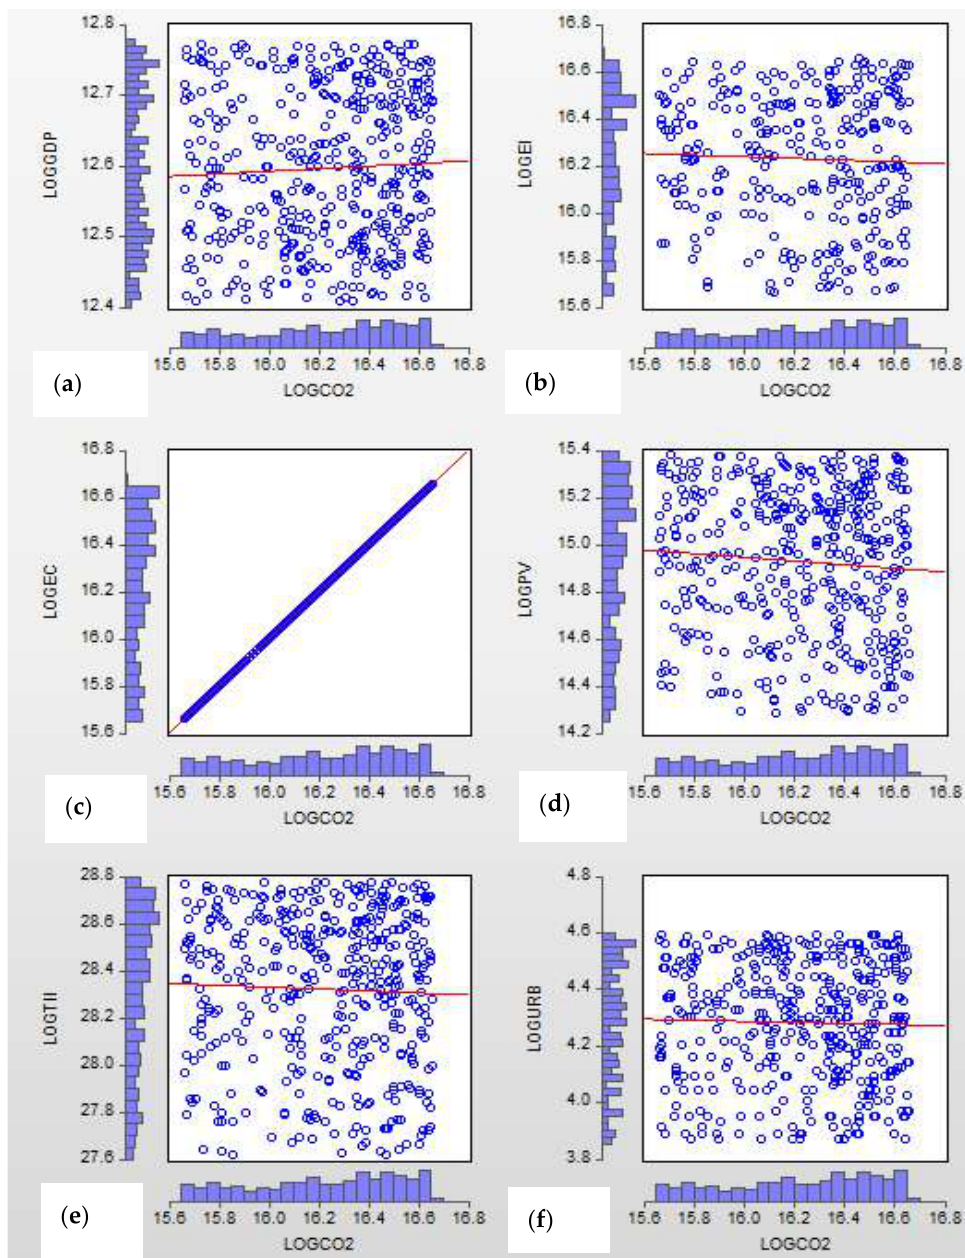
Figure 3. Graphical analyses of an endogenous variable over CO 2 - eq emissions in the transporta- tion sector. Red-rising line: Impact factor leading direction; Blue scattered-plot: CO 2 - eq emitted